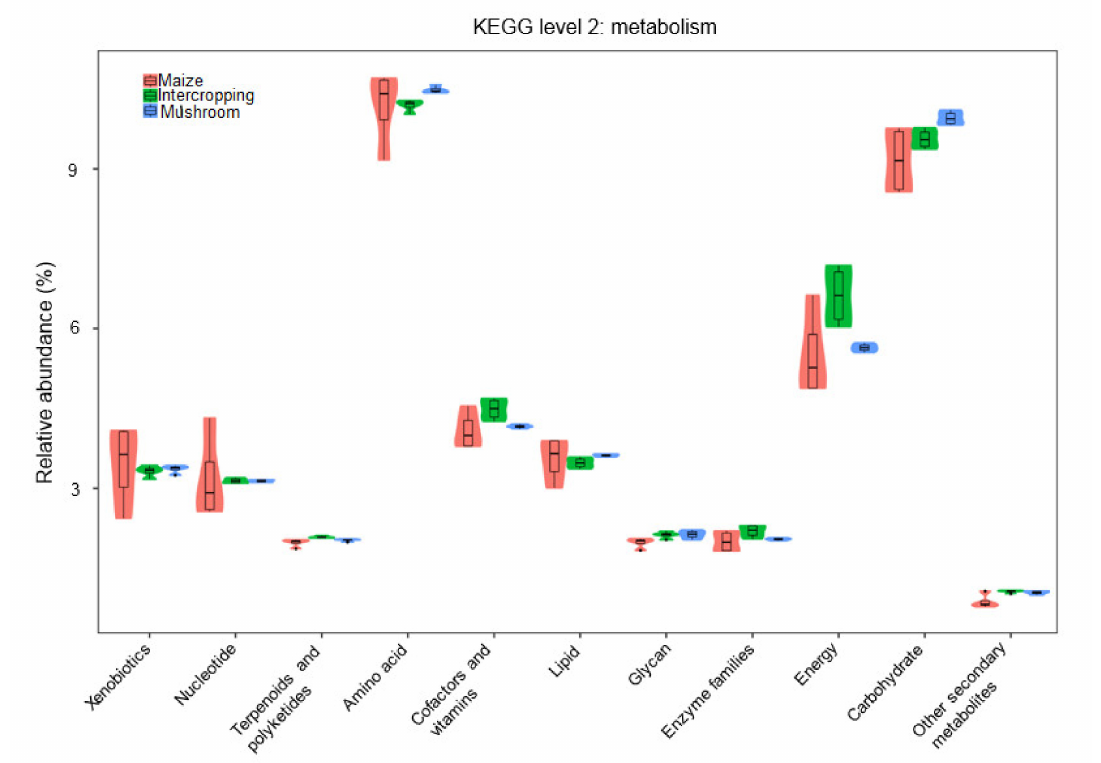
Figure 7. The KEGG metabolic pathway di ff erence analysis of bacteria at 0–20-cm soil depths under maize monoculture, mushroom monoculture and intercropping. The number of replicates per treatment is 4 ( n =